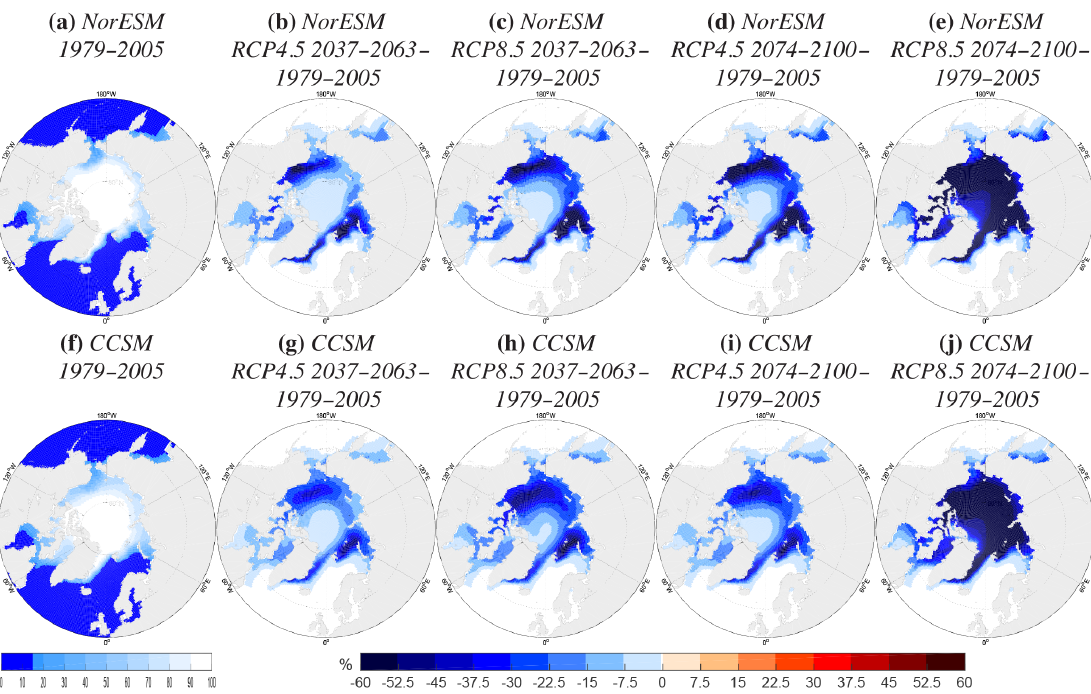
Figure 1. Sea ice concentration (a, f) averages for SOND 1979–2005 and (b–e, g–j) changes in average over various time periods and scenarios compared to 1979–2005 in NorESM (upper row) and CCSM (lower row). The time periods and scenarios are (b, g) RCP4.5 2037– 2063 − 1979–2005, (c, h) RCP8.5 2037–2063 − 1979–2005, (d, i) RCP4.5 2074–2100 − 1979–2005 and (e, j) RCP8.5 2074–2100 − 1979–